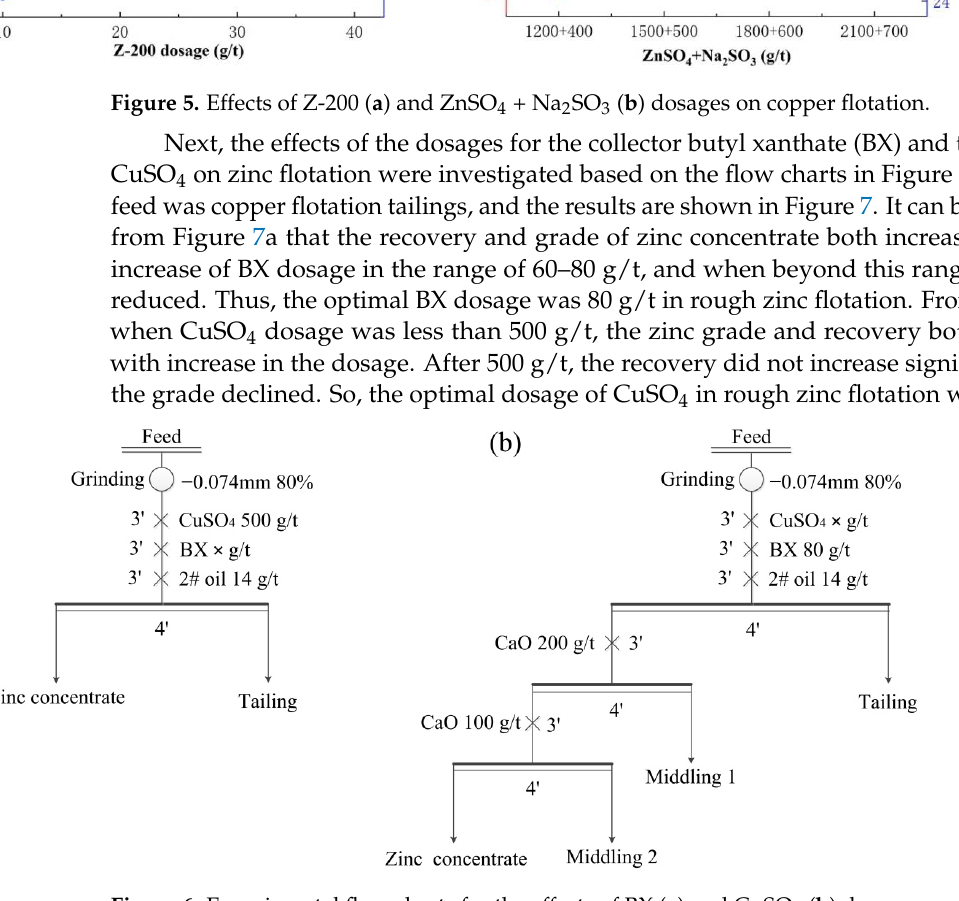
Figure 5. Effects of Z-200 ( a ) and ZnSO 4 + Na 2 SO 3 ( b ) dosages on copper flotation.